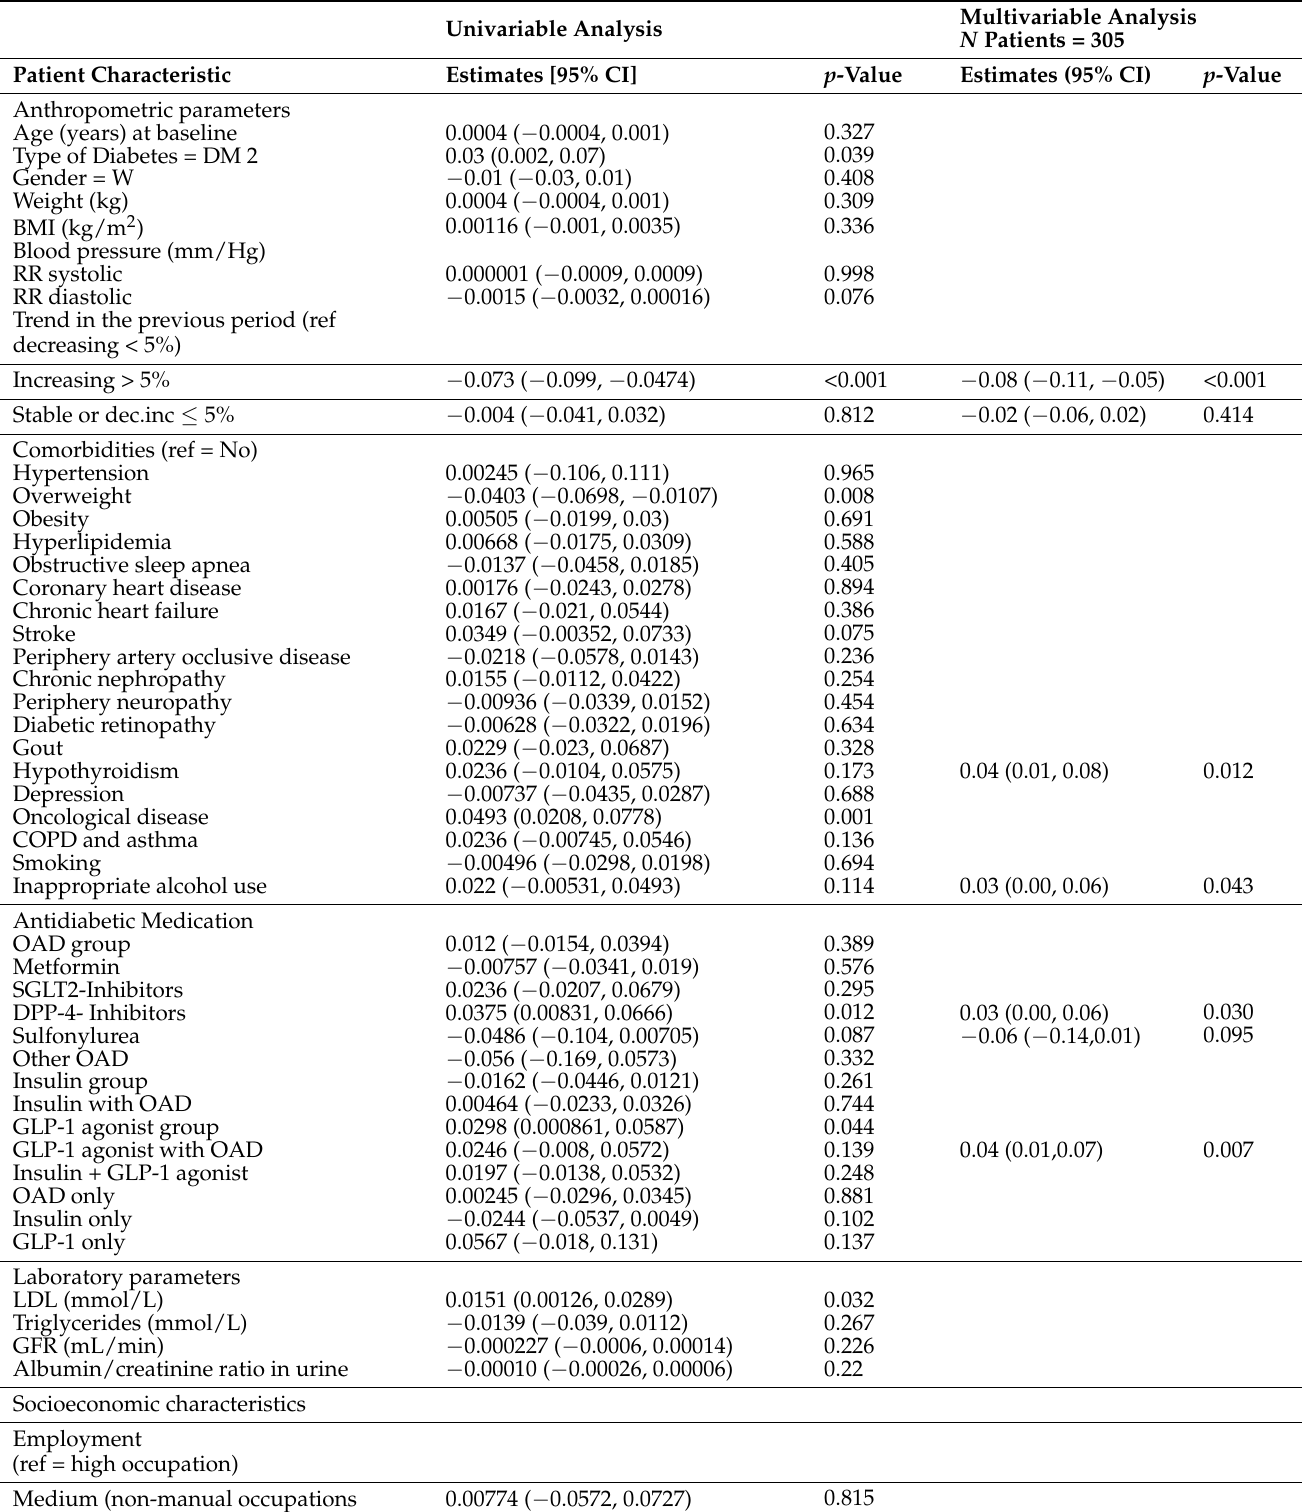
Table 4. Regression Analysis of the Impact of Confounding Factors on the Rate of Change of HbA1c after the Lockdown. Univariable